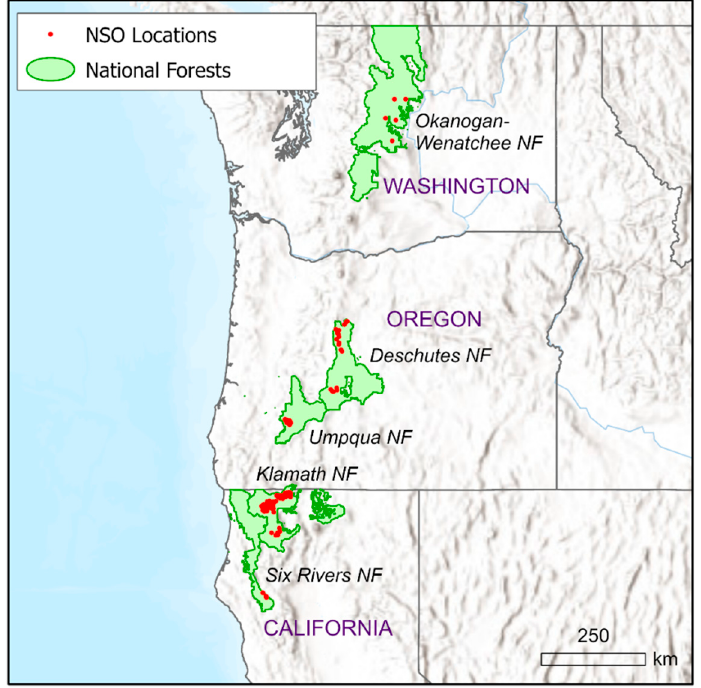
Figure 2. Study area showing the location of severely burned Northern Spotted Owl sites in five national forests where information on logging, wildfires, and Barred Owls was available from 2000–2017.